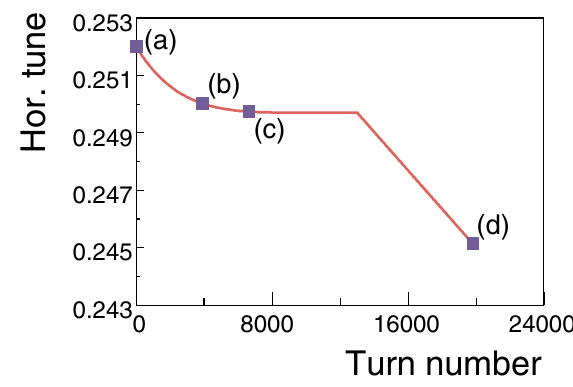
FIG. 5. (Color) Evolution of the tune used for the simulation of a five-turn extraction ( p (cid:1) 5 ). The four points labeled with letters correspond to the tune values at which the beam dis- tribution is shown in Fig. 6.